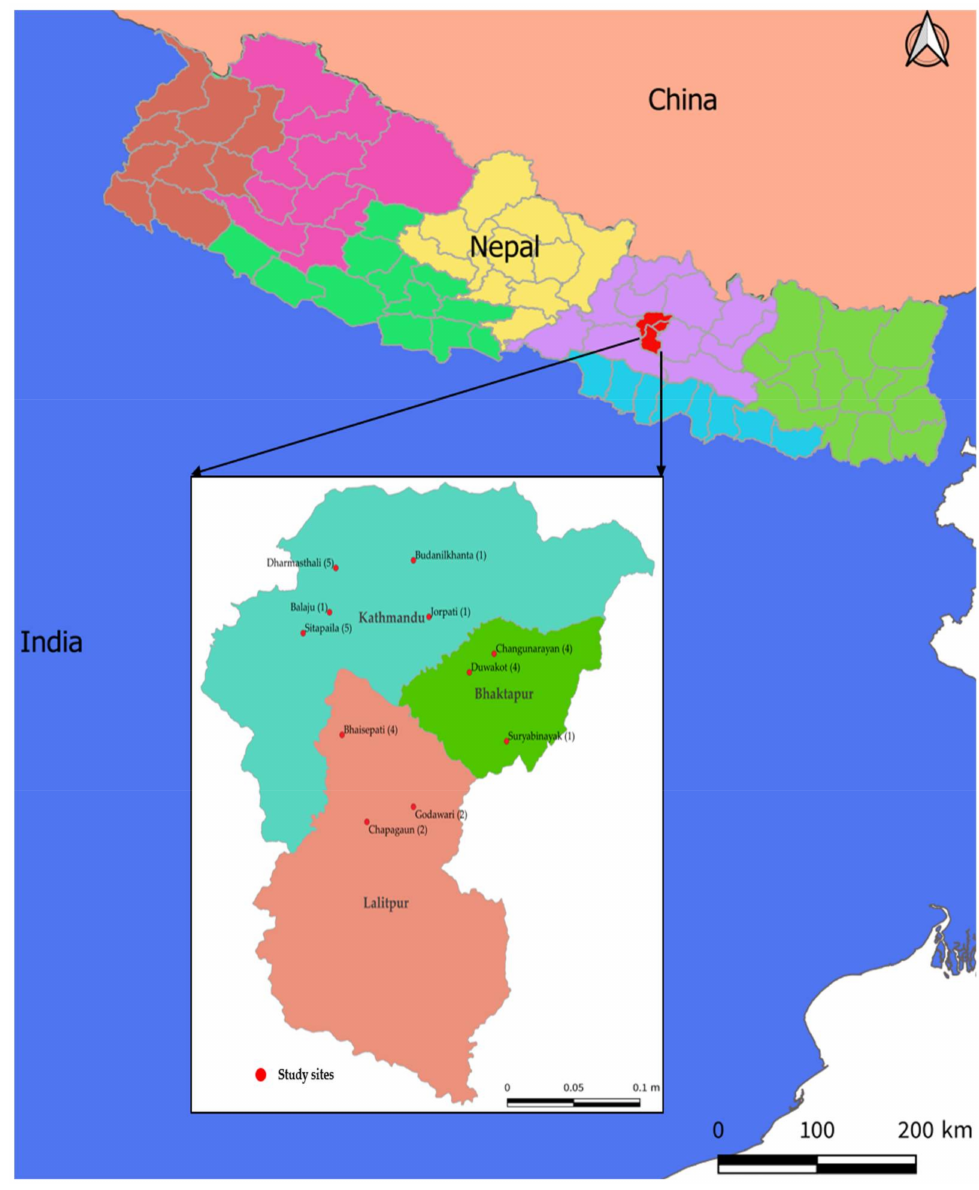
Figure 1. Map of Nepal showing the study sites where antibiotic use in large broiler poultry farms were assessed in Kathmandu valley, Nepal